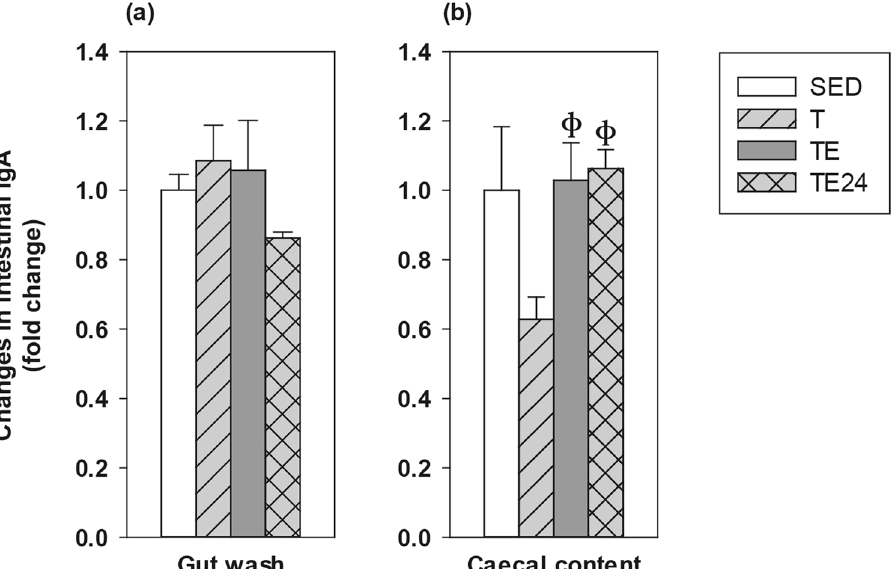
Figure 3. Changes in gut wash IgA ( a ), and caecal content IgA ( b ) concentration compared to the sedentary group. SED sedentary rats, T trained rats, TE T rats immediately after a final exhaustion test, TE24 TE rats 24 h after the final exhaustion test. Data are expressed as mean ± standard error (n = 8). Statistical differences (Kruskal–Wallis followed by Mann–Whitney U test): ф p < 0.05 vs . T group.